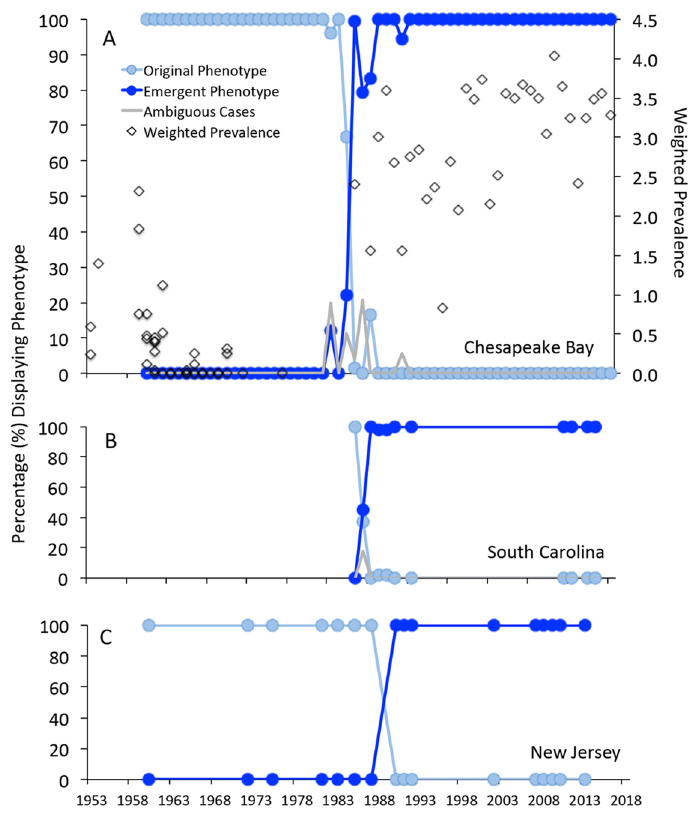
Figure 3. Timing of the Perkinsus marinus phenotype transition in Chesapeake Bay (n = 7932) ( A ), South Carolina (n = 323) ( B ) and New Jersey (n = 100) ( C ). Data presented are the percentages of analyzed oysters from each year and location displaying the original (light blue symbols and lines) or emergent (darker blue) phenotypes. The gray lines in the Chesapeake Bay and South Carolina panels represent ambiguous cases